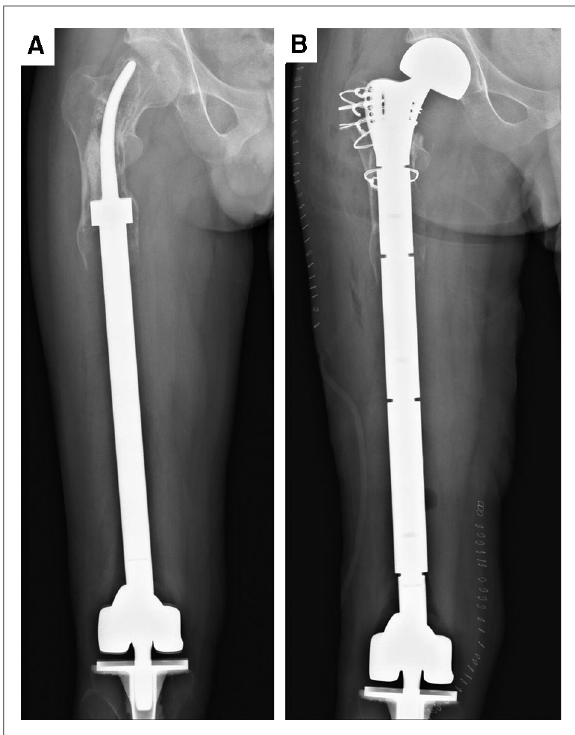
FIGURE 3 Aseptic loosening of the curved stem and revision surgery of case. ( A ) Aseptic loosening of the curved stem at the postoperative 97th month. ( B ) Aseptic loosening of the curved stem in case of revision